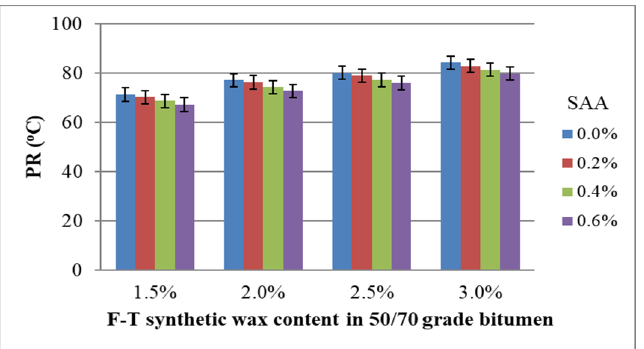
Figure 12. Relationship between the plasticity range of bitumen 50/70 and the contents of F–T wax and SAA.